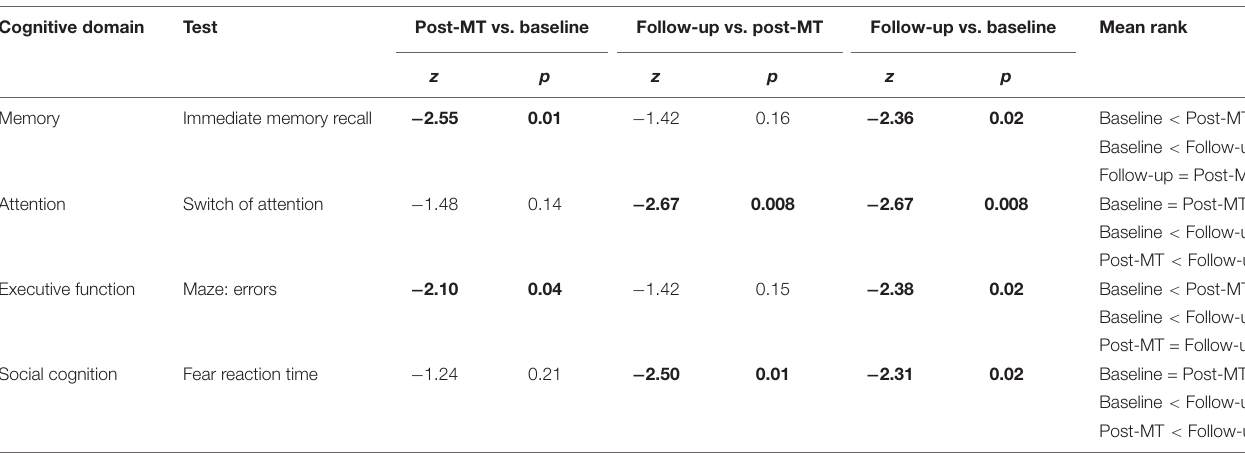
TABLE 3 | A summary of post hoc test results for group two. Cognitive